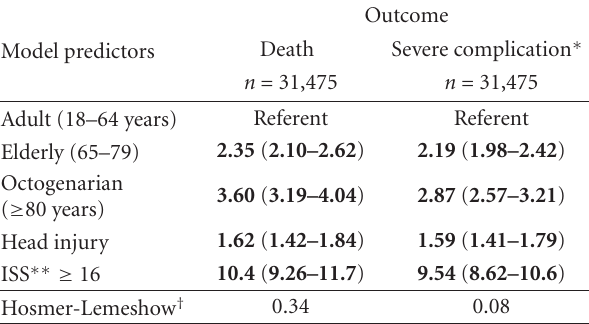
Table 2: Multivariate logistic regression analysis for the entire pop- ulation of closed pelvic fractures using predictors upon arrival to the emergency department with the outcomes death and severe complication (odds ratios and 95% confidence intervals).